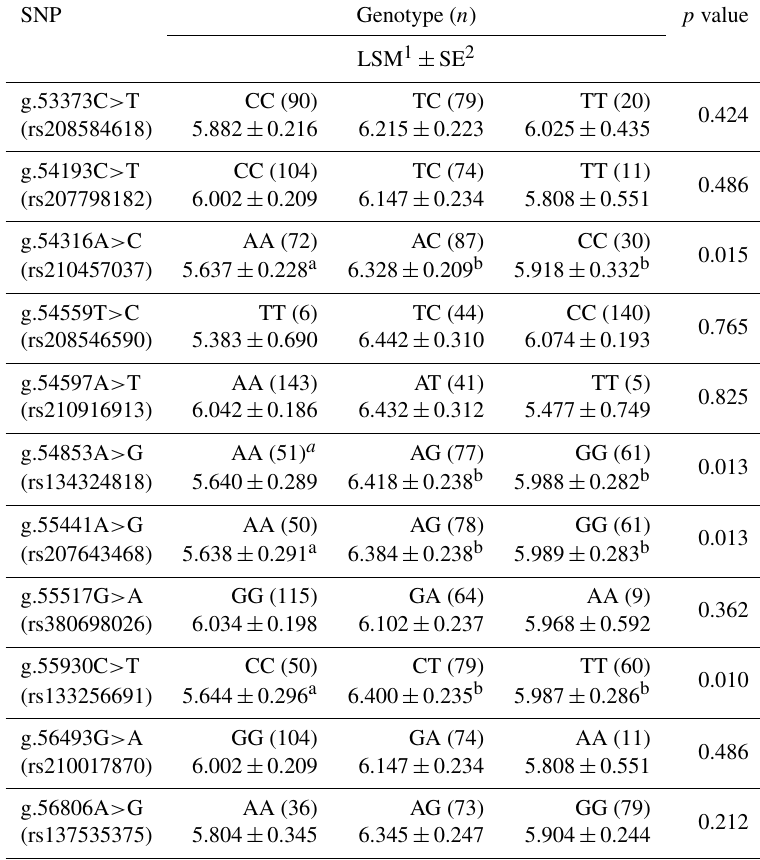
Table 1. Effect of SNPs in the 3 (cid:48) -UTR of the GPAM gene on marbling scores in Korean cattle steer ( n =